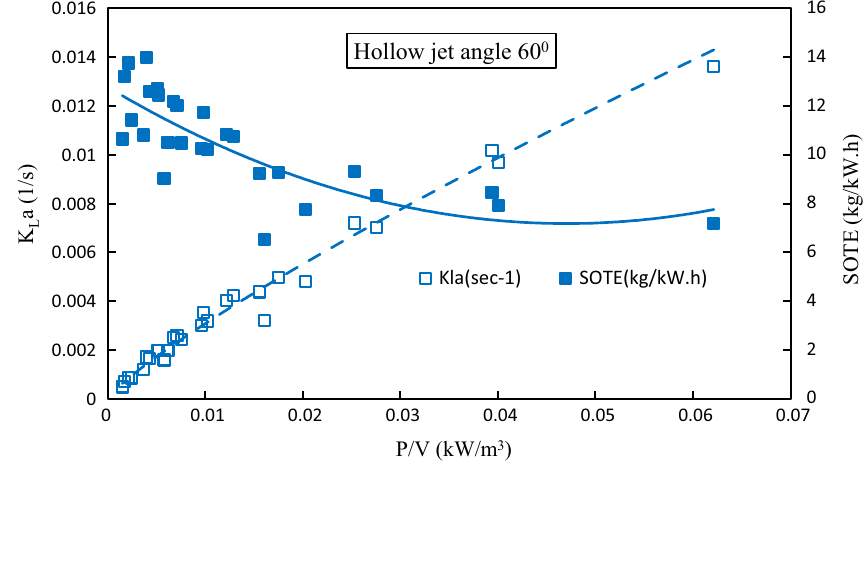
Fig. 5 K L a and SOTE as a func- tion of kinetic jet power per unit volume ( P / V ) of water ( θ = 45°)